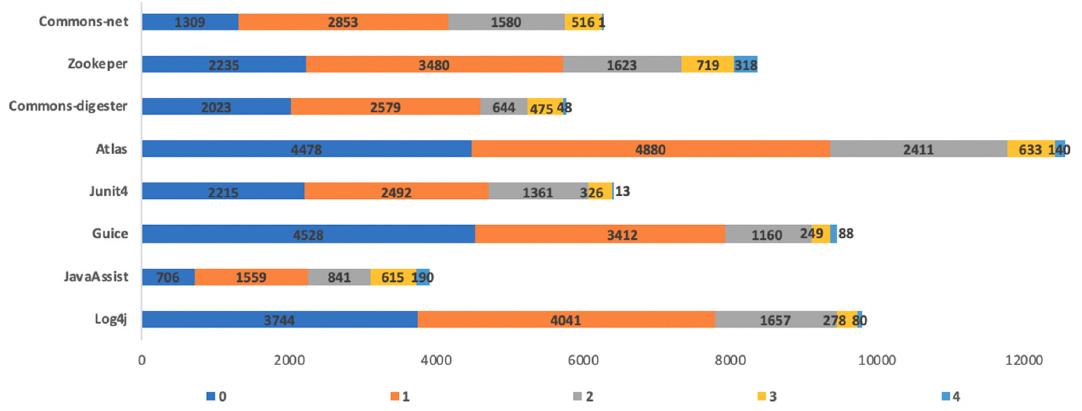
Figure 3. Number of classes that contain one or more smells.